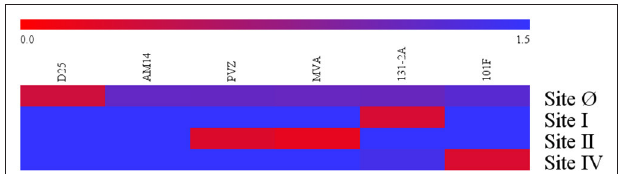
FIGURE 1 | Specificity of RSV antigenic site-specific competitive antibody assays. Blue indicates there was the mAbs had no inhibition to the biotinylated mAbs specific to the RSV antigenic site. Red indicates there were strong inhibition to the RSV antigenic site. The 0.0–1.5 scale represents the level of mAb inhibition from the strongest to the weakest. PVZ, palivizumab; MVA, motavizumab. Data represented are from 3 independent duplicate competitive antibody